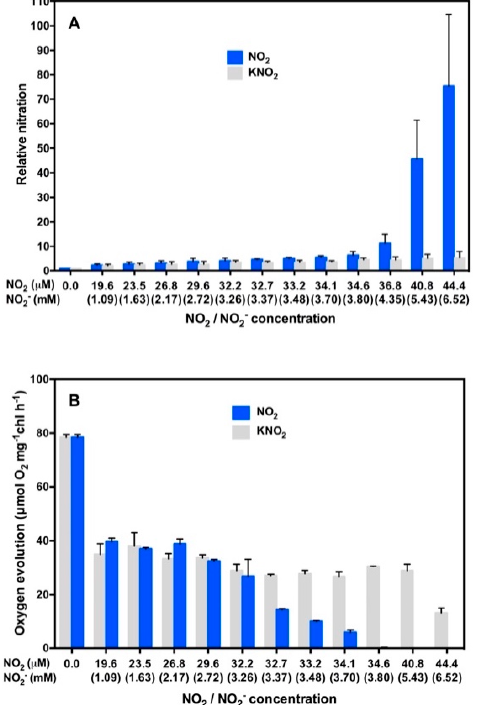
Figure 7. Demonstration that nitration of PsbO1 inhibits oxygen evolution. Arabidopsis thylakoid membranes were incubated in light in a buffer containing NO 2 and NO 2 − or a buffer containing NO 2 − alone. Incubated thylakoid membranes were divided into equal parts: first one for Western blot analysis and second one for oxygen evolution analysis. ( A ) Relative nitration of PsbO1 as a function of concentrations of NO 2 or NO 2 − . ( B ) Oxygen evolution as a function of concentrations of NO 2 or NO 2 . The data represent the mean ± SD of three independent experiments.